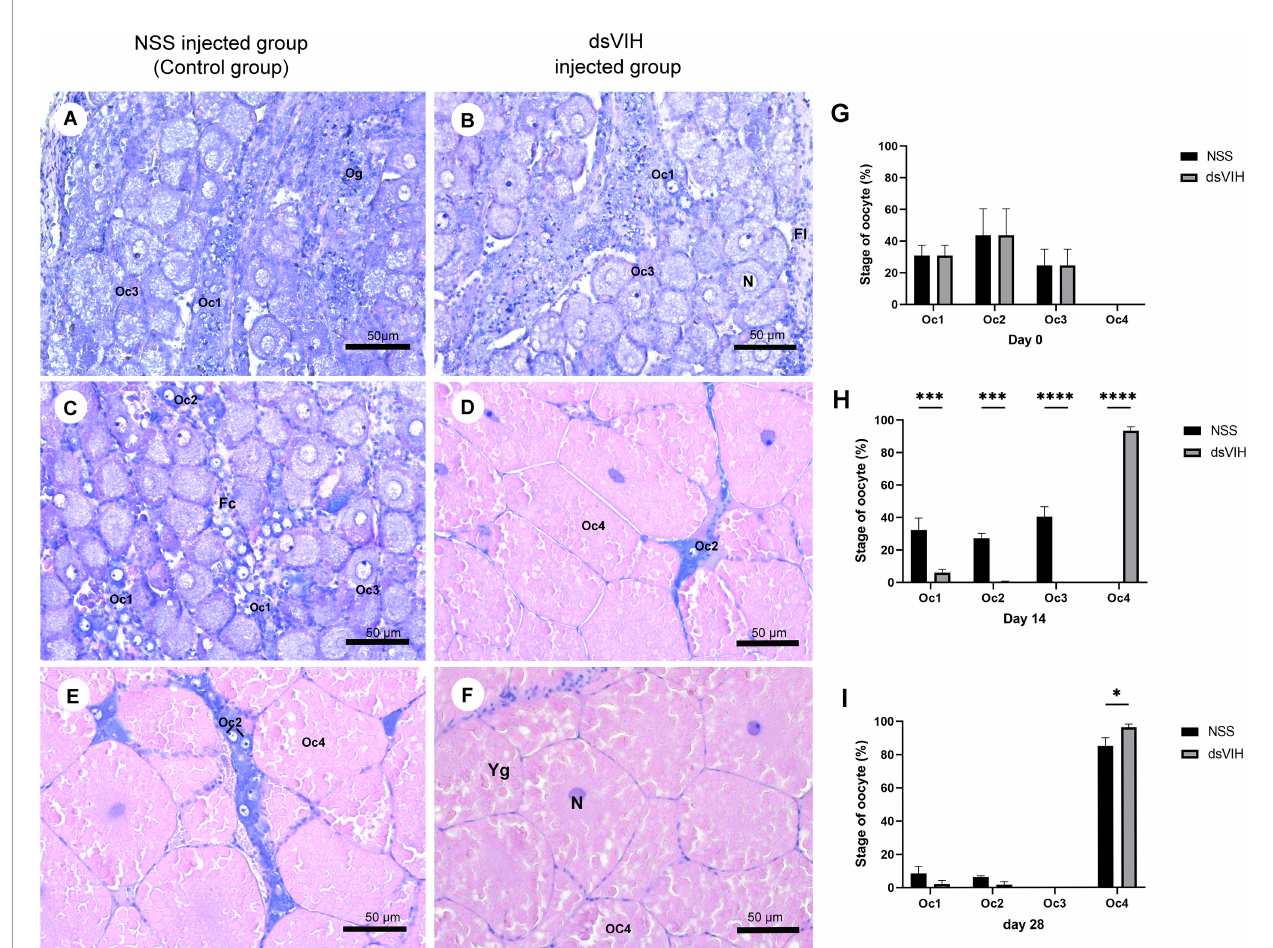
FIGURE 6 | Histological analysis of the ovaries of dsRNA-VIH and NSS treated crabs. A representative sample from each group is shown. (A, B) At day 0, ovaries in both group showed oogonia (Og) and three steps of oocyte (Oc1-Oc3) (C, D) At day 14, NSS injected group and dsRNA-VIH injected group showed Oc1 that clearly displayed euchromatic nucleus, Oc2 that was oval and was surrounded by follicular cells, Oc3 that was oval and it contained mostly euchromatin and prominent nucleolus with small lipid droplets in cytoplasm, and Oc4 that was fully mature oocyte with large spherical ovoid shape and heavy lipid droplets in cytoplasm. (E, F) At day 28, the dsRNA-VIH injected group showed more Oc4 than that of the NSS injected group while the latter also showed some pre-mature stage (Oc1-Oc2). (G – I) Quanti fi cation of the oocyte stage on day 0, 14 and 28. Asterisks indicate signi fi cant differences compared to the NSS injected group and dsRNA-VIH injected group with * p < 0.05, *** p < 0.001, **** p < 0.0001. Oocyte developmental features are indicated as Yg, yolk granule oocyte; Oc, oocyte, Og, oogania; Fc, foccicle cell; N,